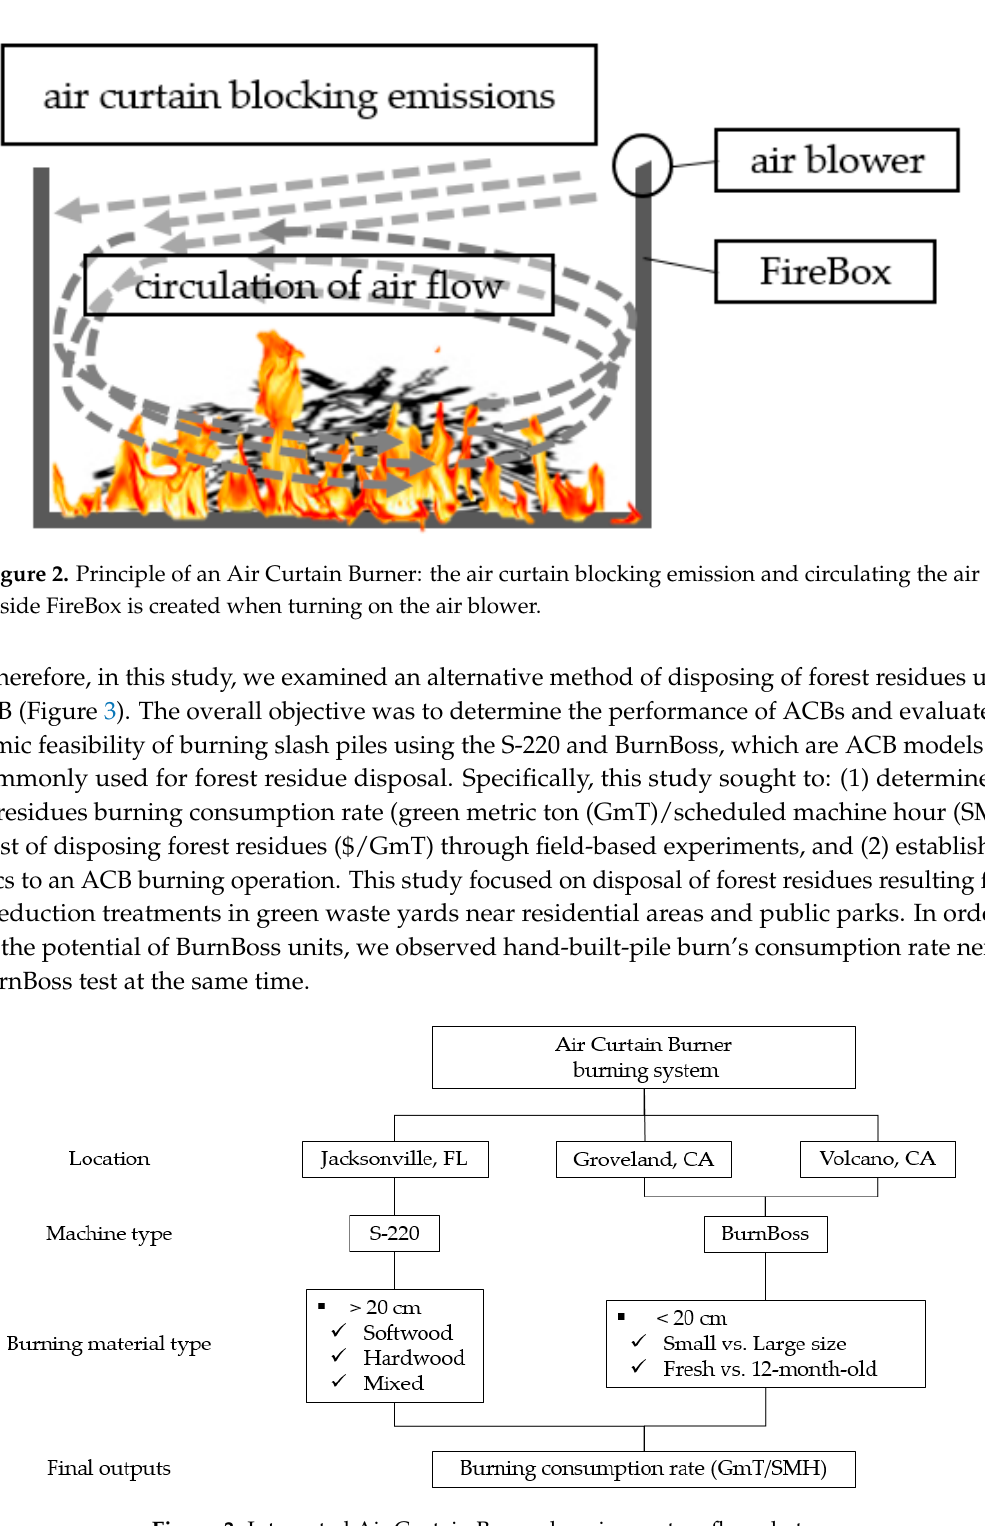
Figure 3. Integrated Air Curtain Burner burning system flow chat.